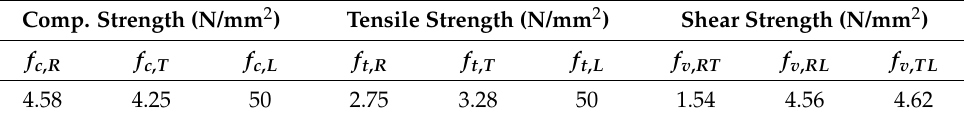
Table 4. Wood material’s strength properties for FE